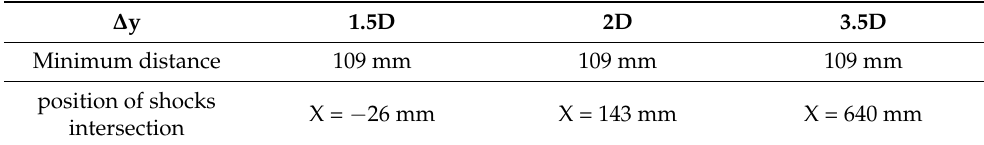
Table 3. Minimum distance between shock wave and stagnation point of debris and location of intersection of shock waves.